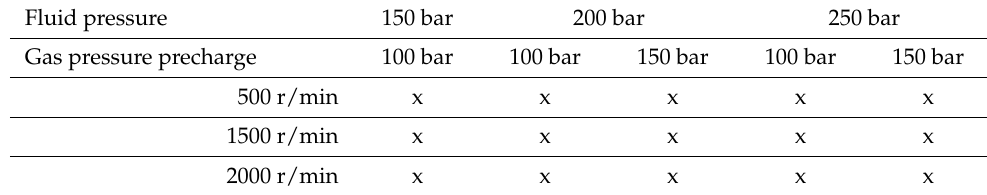
Figure 2. Scheme of the circuit layout. Table 1. Pump working conditions.